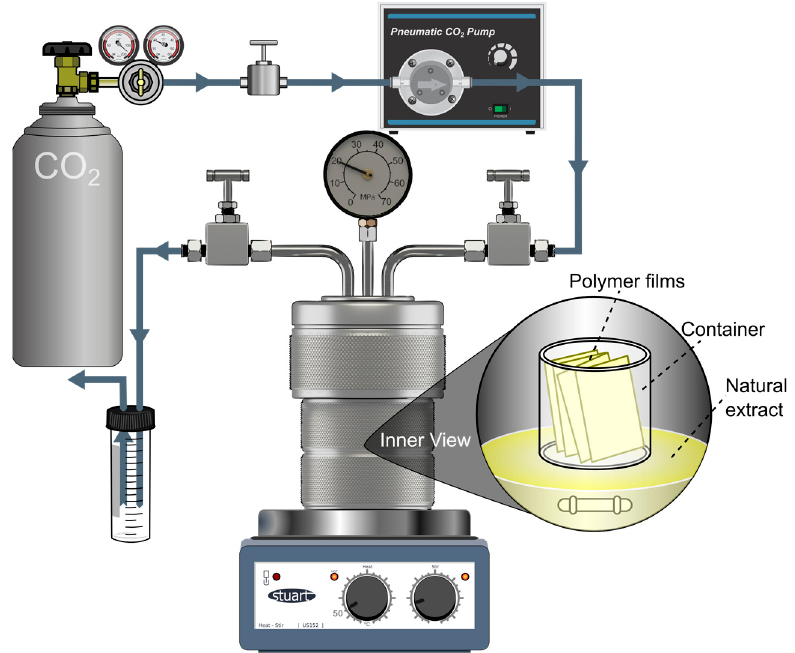
Figure 3. Scheme of the experimental